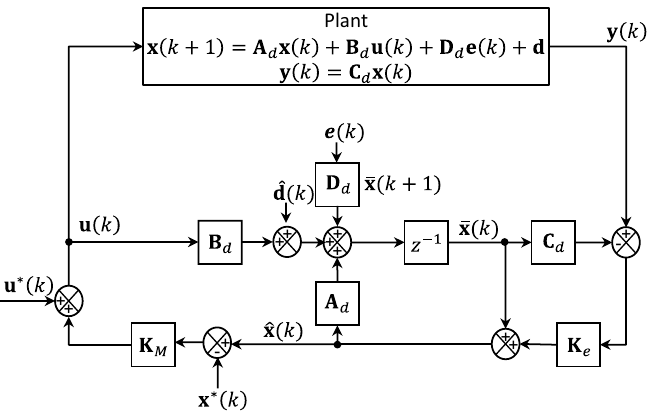
Figure 3. Block diagram of the LMI-based current-type full-state observer.